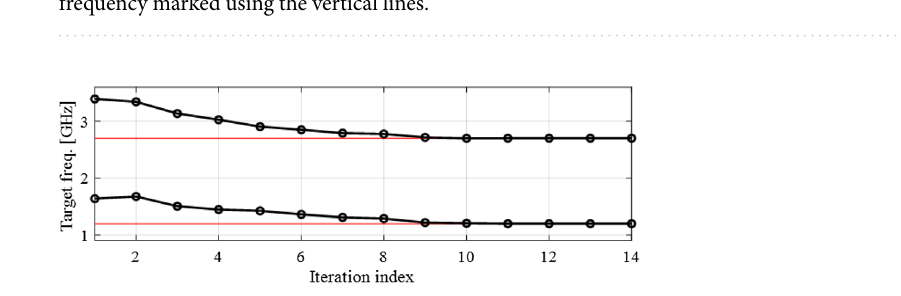
Figure 10. Dual-band branch-line coupler: scattering parameters at the initial (top) and the final design (bottom) obtained using the proposed design specification management methodology. Target operating frequency marked using the vertical lines.